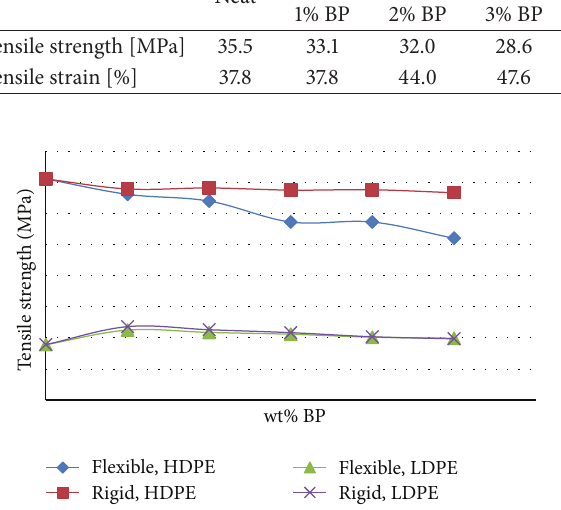
Figure 4: Tensile strengths for all specimens injected at respective compositions.